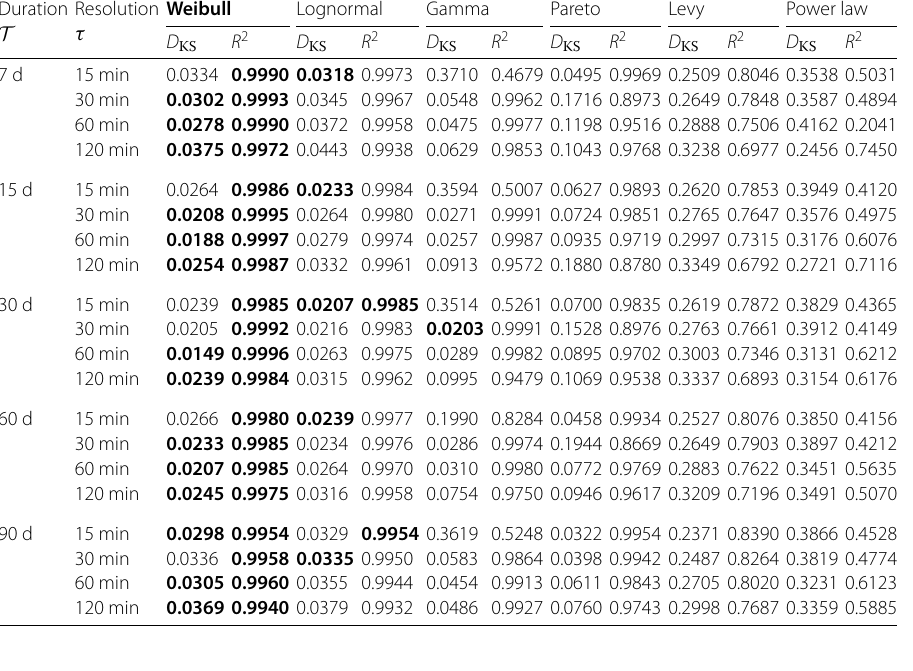
Table 2 Empirical fittings of the completeness of trajectories. Fitting quality of six standard long-tailed distributions to the empirical PDF of trajectory completeness, in terms of R 2 and D KS . Rows refer to different combinations of observation period T and time resolution τ . Best-fit R 2 and D KS are highlighted in bold Duration Resolution Weibull T τ